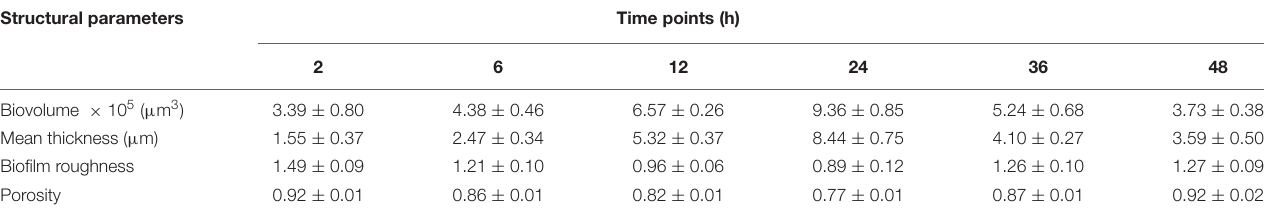
TABLE 1 | Quantification of the biofilm structure of V. parahaemolyticus after 2, 6, 12, 24, 36, and 48 h of incubation. Structural parameters